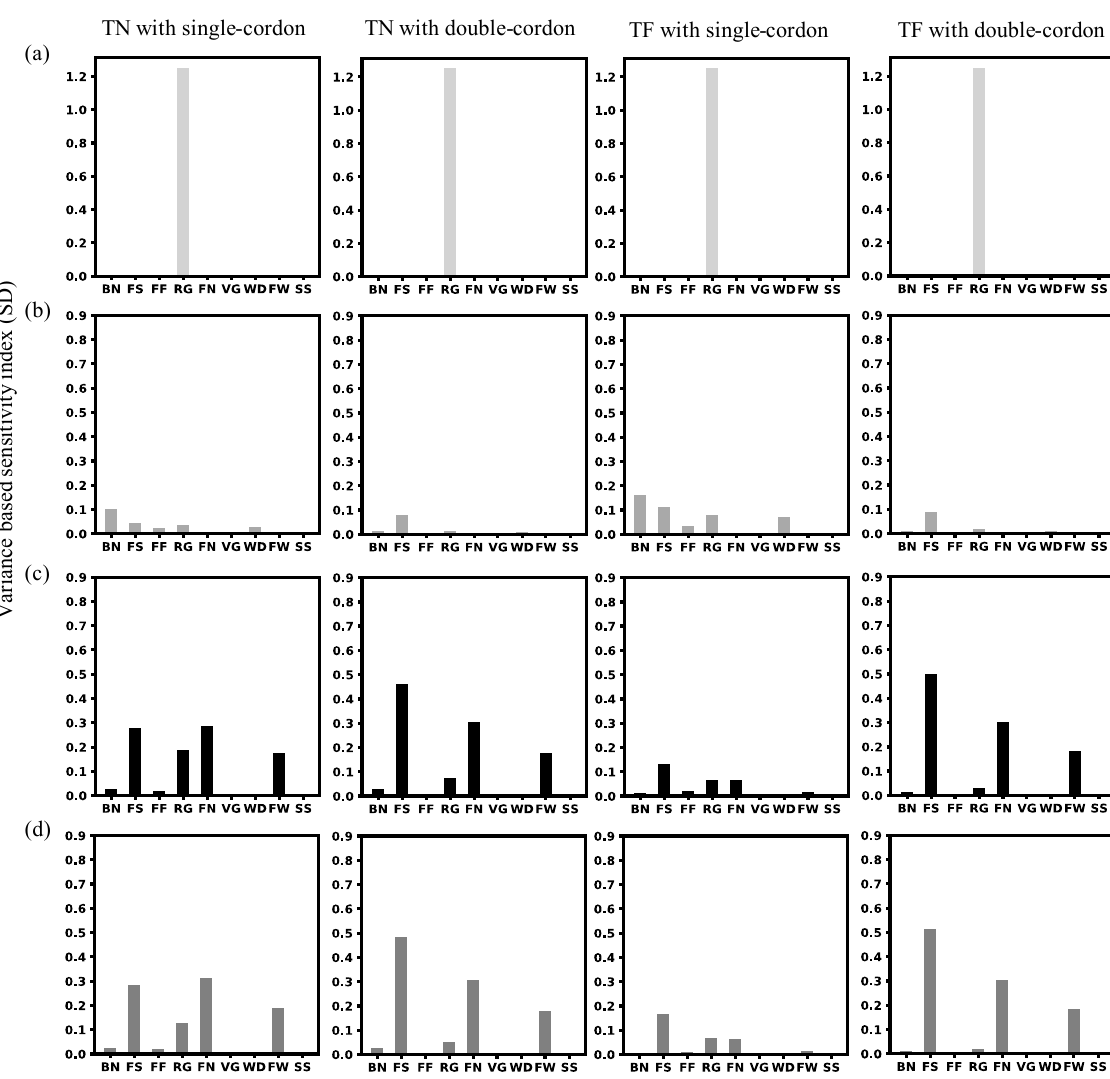
Figure 4. The variance-based sensitivity index is calculated for each variety–training system combination based on the variance of the total prediction uncertainty (nRMSE, %) over the response variable of ( a ) flowering date; ( b ) harvest date; ( c ) yield; ( d ) combined variable (i.e., objective function). The index denotes the main effect index, which can rank the relative importance of each parameter in terms of its individual effect on the total variance of the prediction uncertainty (nRMSE, %). Parameter abbreviations are labelled on the x- axis with detailed parameter descriptions in Table 2.